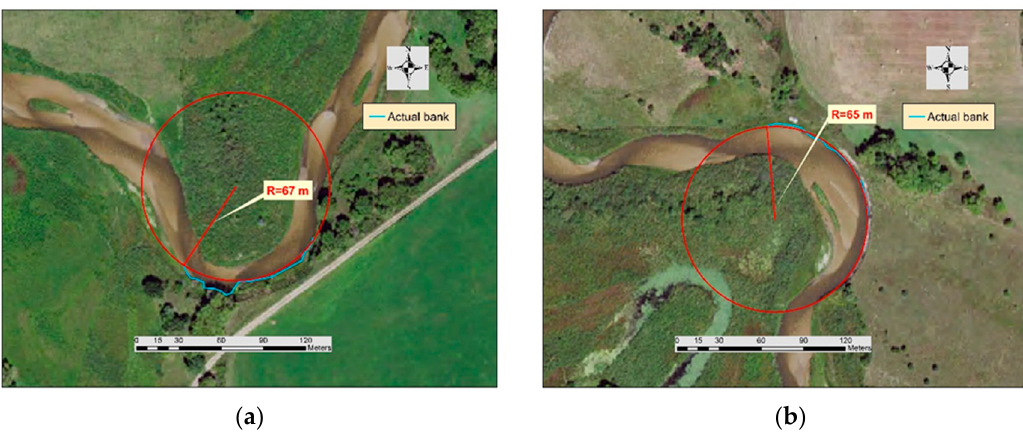
Figure 5. The left image ( a ) shows the radius of curvature of the stabilized bank (Site 4) in 2016; the right image ( b ) shows the radius of curvature of one of the three control sites for Site 4 (The radius was 64 m in 1993). Note that both sites have cropland on the outer bank and dense trees on the inside bank. The flow direction is from left to right.